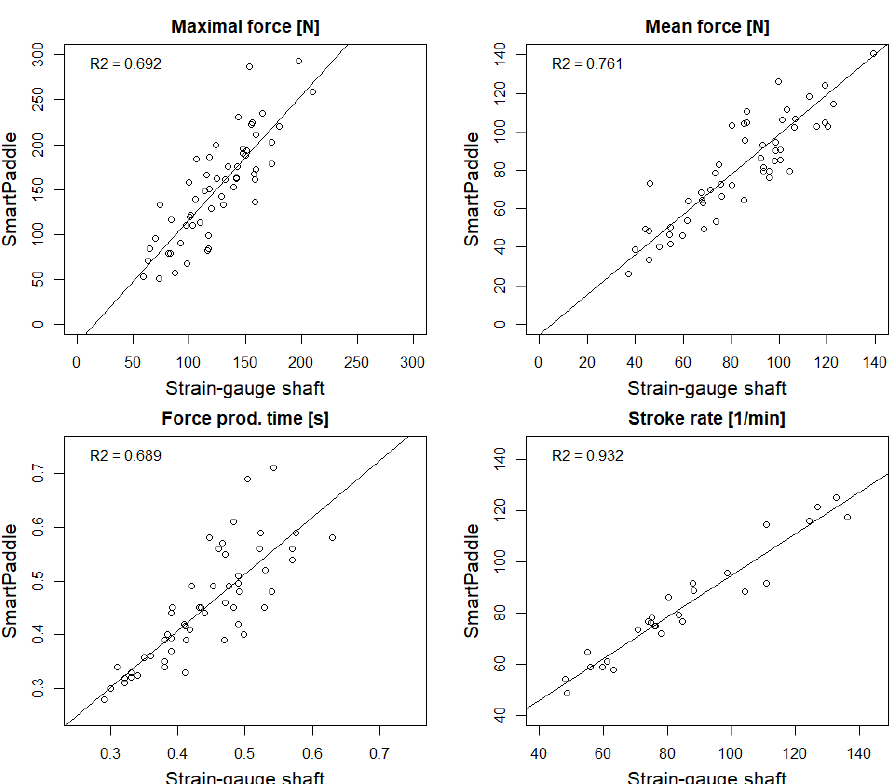
Figure 2. Scatter plots and R 2 values between SmartPaddle and strain-gauge shaft in key paddle stroke variables ( n = 6) (R 2 = coefficient of determination showing how close the data are to the fitted regression line).